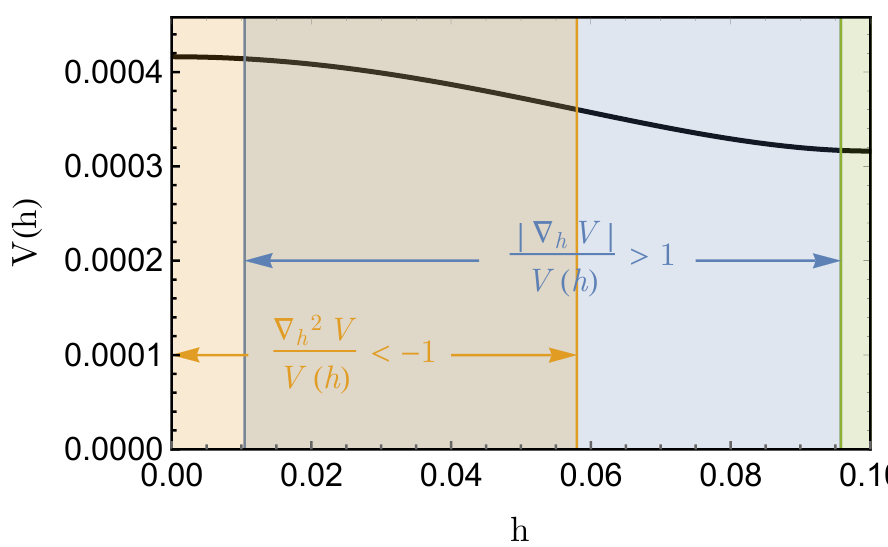
Figure 1 . An example scalar potential (e.g. the Higgs potential) with spontaneous symmetry breaking, with parameters exaggerated for clarity. In the blue region, the (R)dSC is satis(cid:12)ed by the h itself. In the orange region, the RdSC is satis(cid:12)ed along the h direction. In the green region near the minimum along the h direction, a \quintessence" (cid:12)eld is needed to satisfy (R)dSC. If (R)dSC is satis(cid:12)ed at the minimum, then it is satis(cid:12)ed in all the green region (see text for